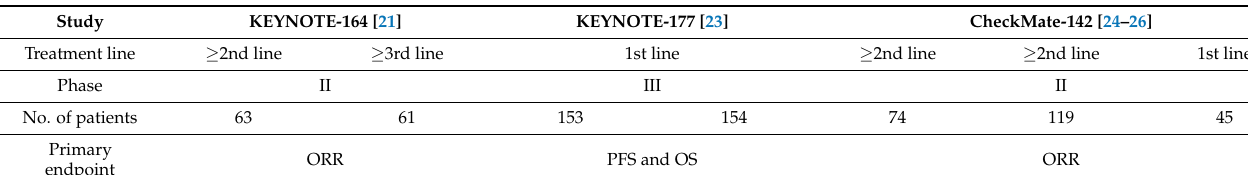
Table 1. Clinical trials for MSI-H/dMMR CRC.